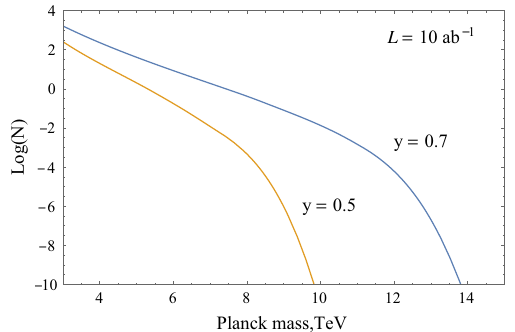
Fig. 4 The amount of the neutral black holes trapped inside the Earth during the lifetime of the future 100 TeV collider (integrated luminosity L = 10 4 fb − 1 ) with the suppression factor Eq. (12) taken into account and for two values of the inelasticity y = 0 . 5 and y = 0 .